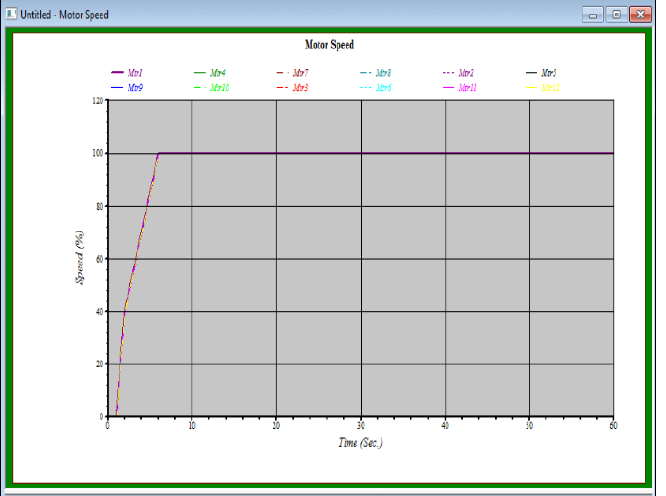
Figure 15: The starting speed after insertion of VFDs. Source: Authors, (2020).